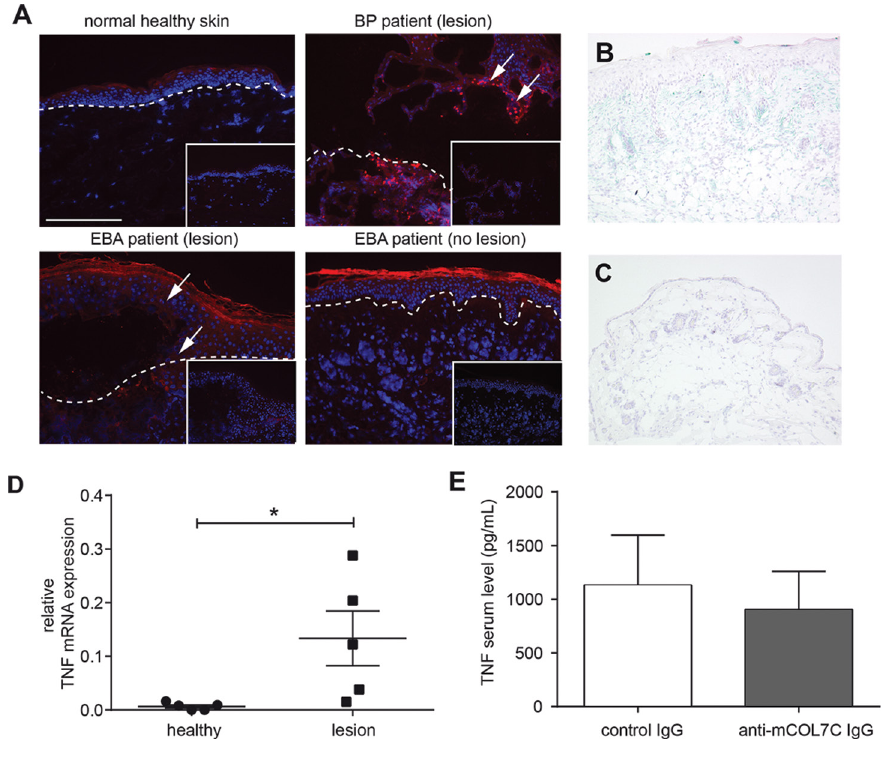
Figure 1. Tissue expression of TNF was increased in experimental EBA. (A) Immunofluores- cence staining of skin obtained from human BP and EBA patients and normal human skin. Red color indicates the presence of TNF only in lesional skin from EBA or BP patients. Inlay: isotype control staining. Images shown are representative of three specimens investigated per group. (B,C) Immunohistochemistry staining of ear skin obtained from (B) an anti-mCOL7C IgG-injected mouse and (C) a normal rabbit IgG-injected control mouse (scale bar: 400 μ M). Blue color indicates the presence of TNF. (D) Ear samples from lesional skin (lesion, n = 5) and healthy areas (healthy, n = 5) after antibody transfers of anti-mCOL7C IgG were analyzed for mRNA levels of TNF by real-time PCR (n = 5/group, * p = 0.0382). (E) TNF concentration was measured by Bio-Plex in the serum of antibody transfer–induced EBA (anti-mCOL7C IgG, n = 7) and normal rabbit IgG–injected animals (control IgG, n = 4) 12 d after the first IgG injection. No significant difference was observed between the two